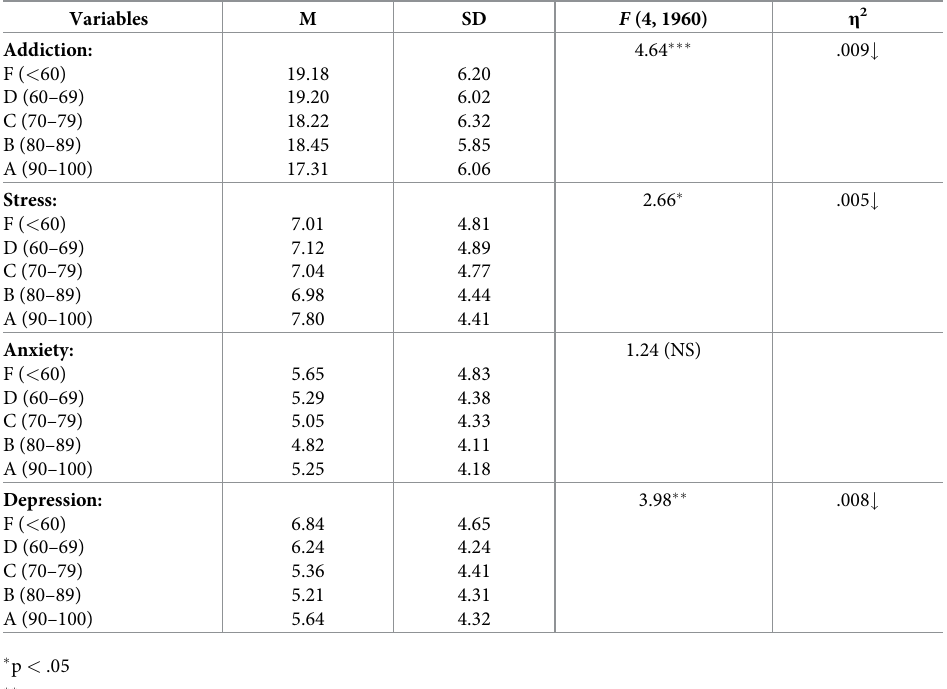
Table 7. Means, SDs, and ANOVA for the variables according to school performance level.